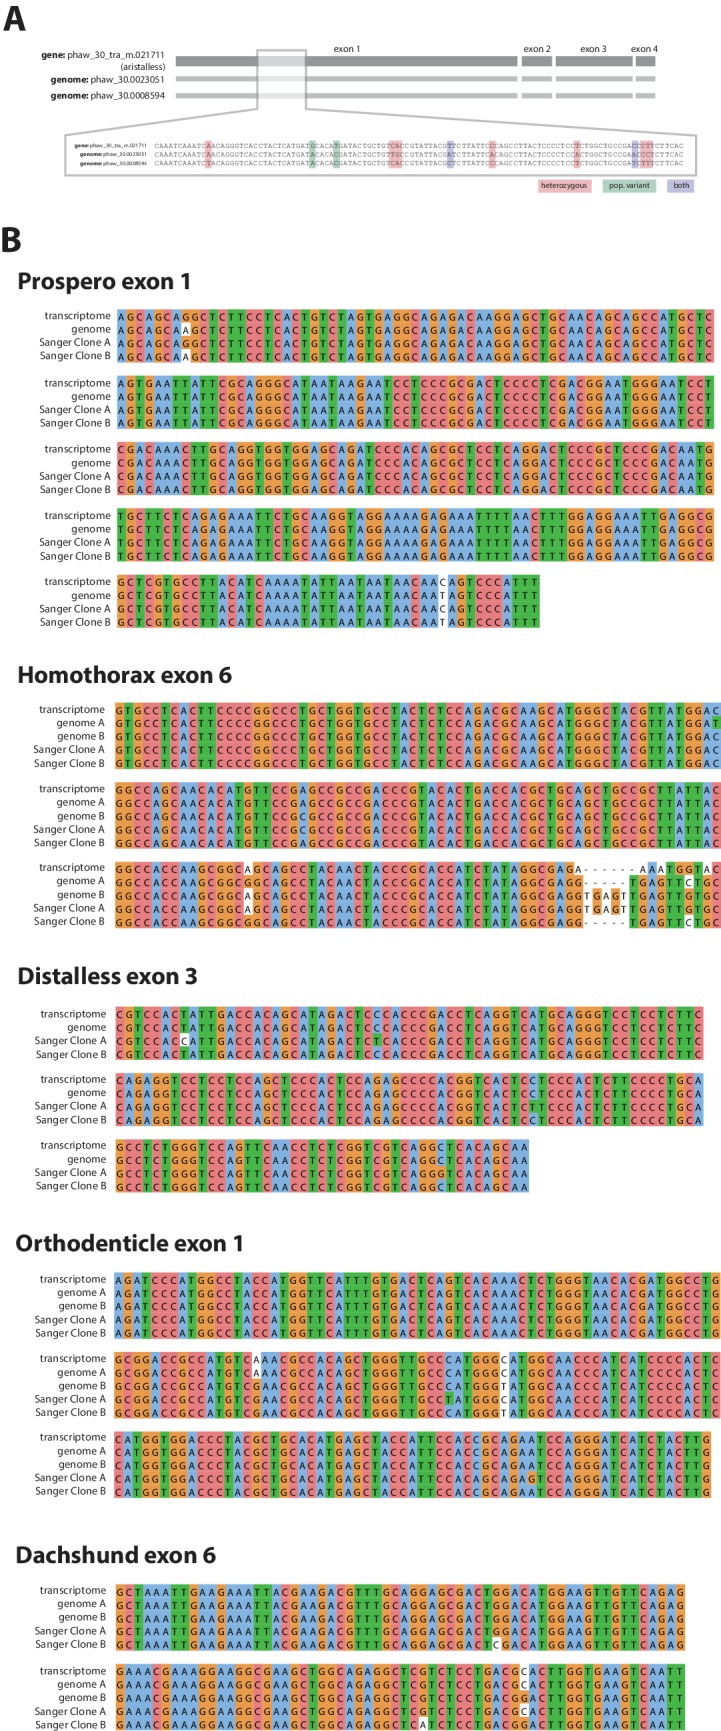
Confirmation of polymorphisms in the wider laboratory population of Parhyale.(A) An example of laboratory population polymorphism in exon 1 of the gene aristalless. As well as heterozygoisty in the single Chicago-F male sequenced (pink and purple bases) there is additional polymorphism detectable in the transcriptome (green bases) (B) Further examples of polymorphism in the laboratory population in 5 developmental genes.